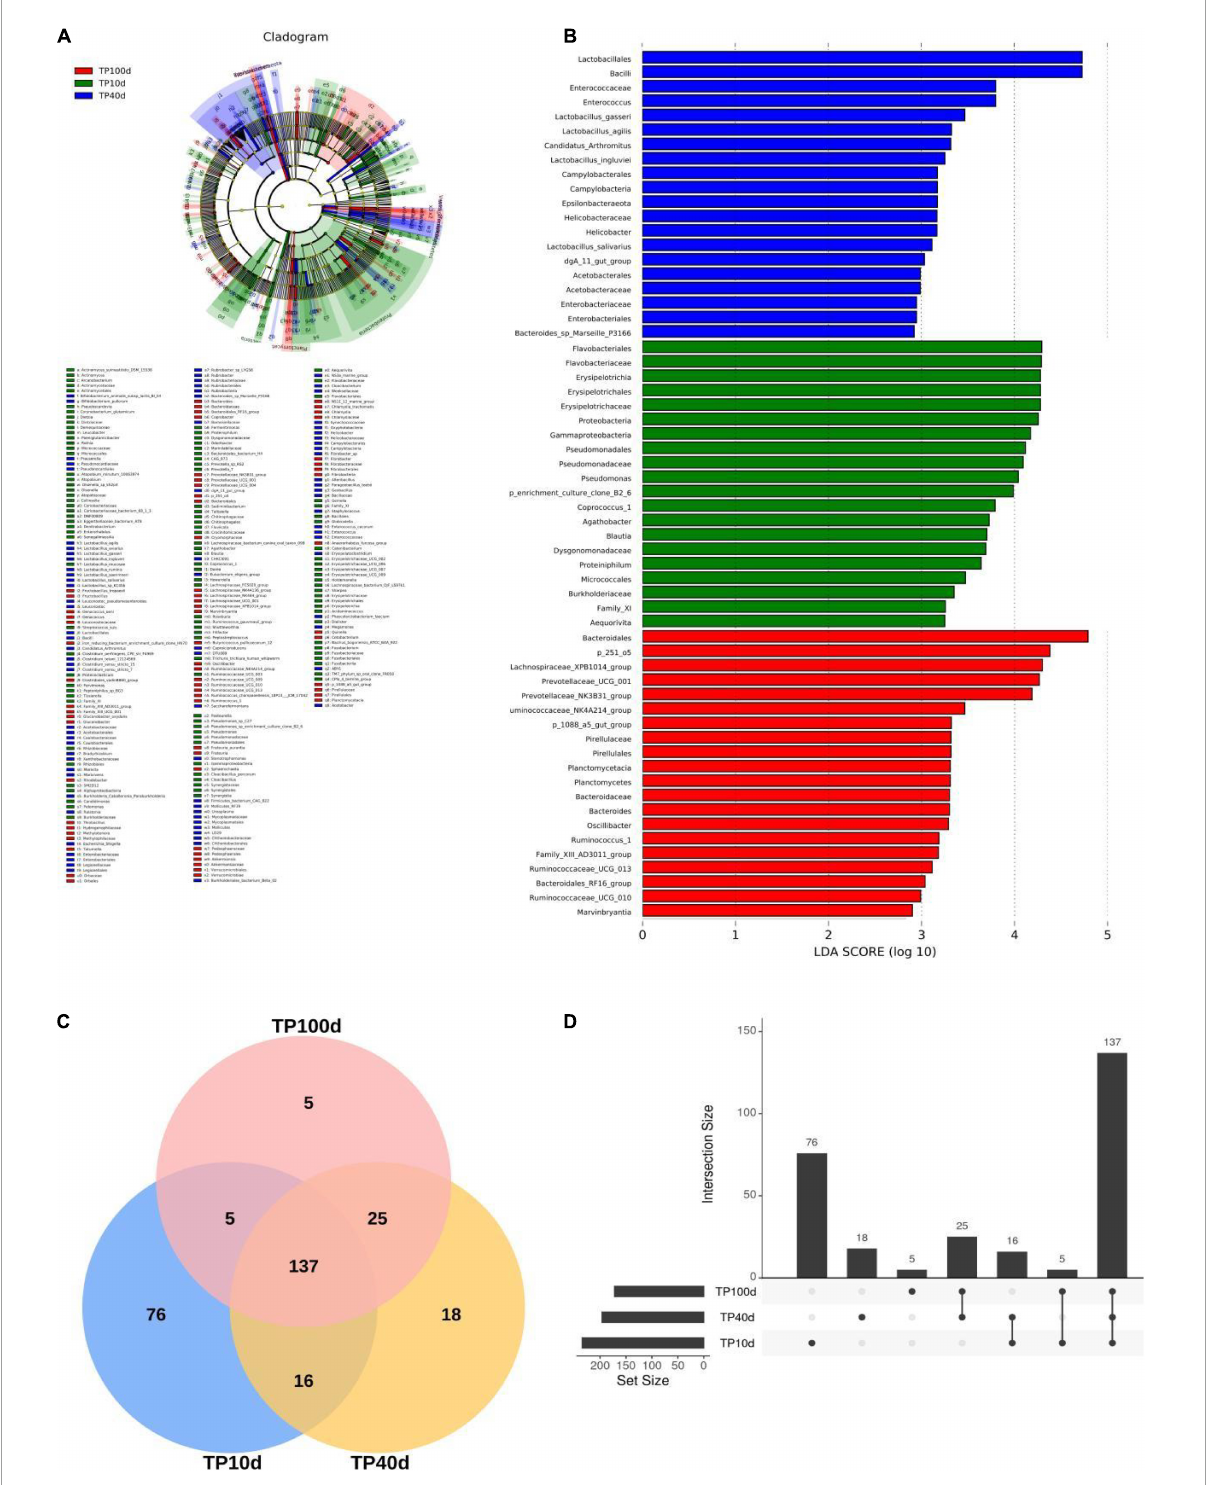
FIGURE5 Comparison of differences in gut microbiota of pigs at different days of age. (A) and (B) are LEfSe analysis plots. (C) Venn plots of different age groups; (D) Figure shows the difference of gut microbiota between different days of